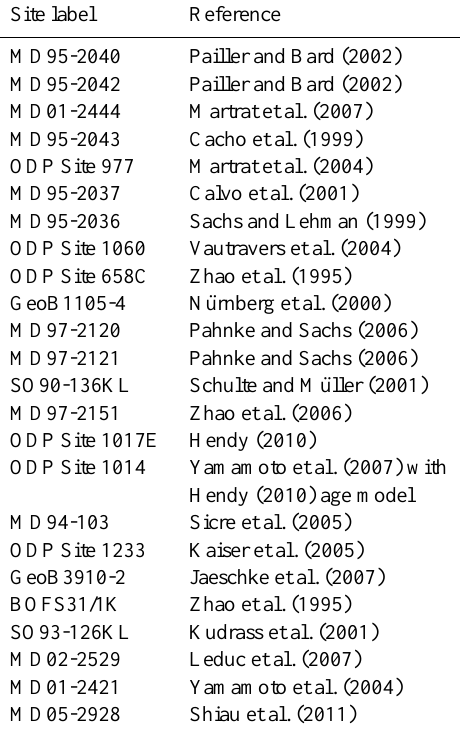
Table A1. Proxy records of SST based on alkenones included in this study. Each record is identified by the site